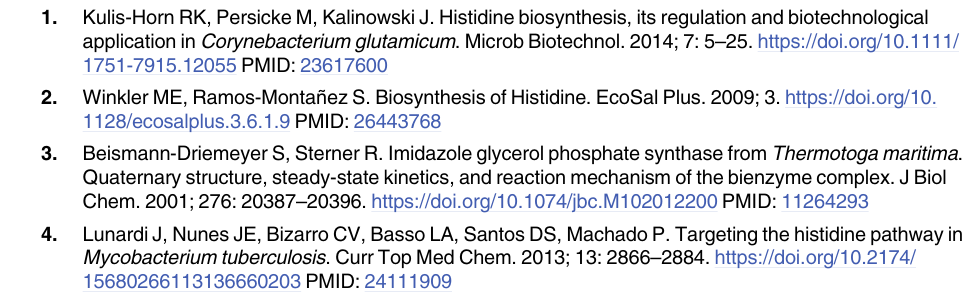
S3 Table. Thermodynamic parameters of the HisF and HisH binding in different tempera- tures calculated from isothermal titration calorimetry experiments. (PDF) S1 Fig. HisF-HisH heterodimer showing the relative positioning between the active sites and the dimerization interface. (PDF) S2 Fig. Interface of the HisF-HisH heterodimer. (PDF) S3 Fig. Analysis of the HisF and HisH binding at different temperatures using isothermal titration calorimetry (ITC). (PDF) S4 Fig. Binding between HisF and HisH followed in isothermal titration calorimetry (ITC). (PDF) S5 Fig. Hydrophobicity index of the residues forming the interface of the HisF-HisH het- erodimer.